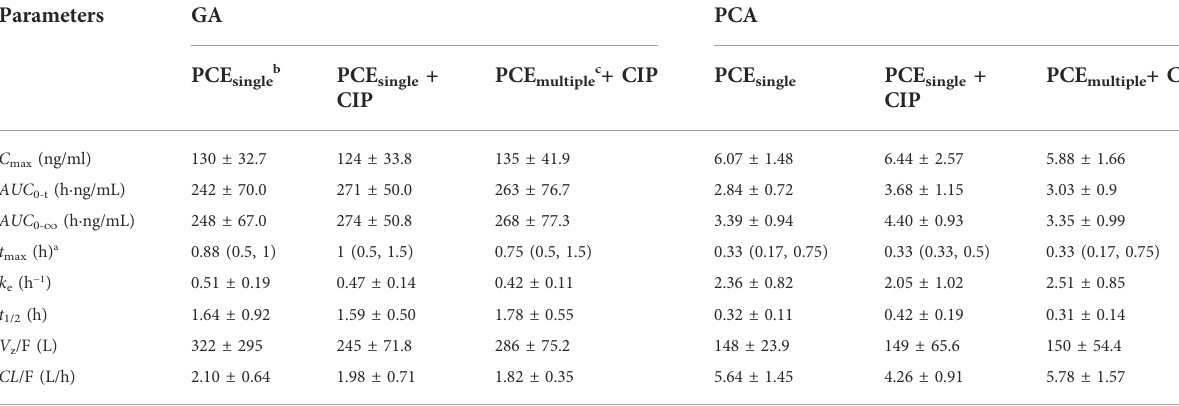
TABLE 2 Pharmacokinetic parameters of gallic acid (GA) and protocatechuic acid (PCA) after the oral administration of PCE (8 g) with and without cipro fl oxacin hydrochloride tablets (CIP, 0.5 g) to human subjects (mean ± SD, n = 12).